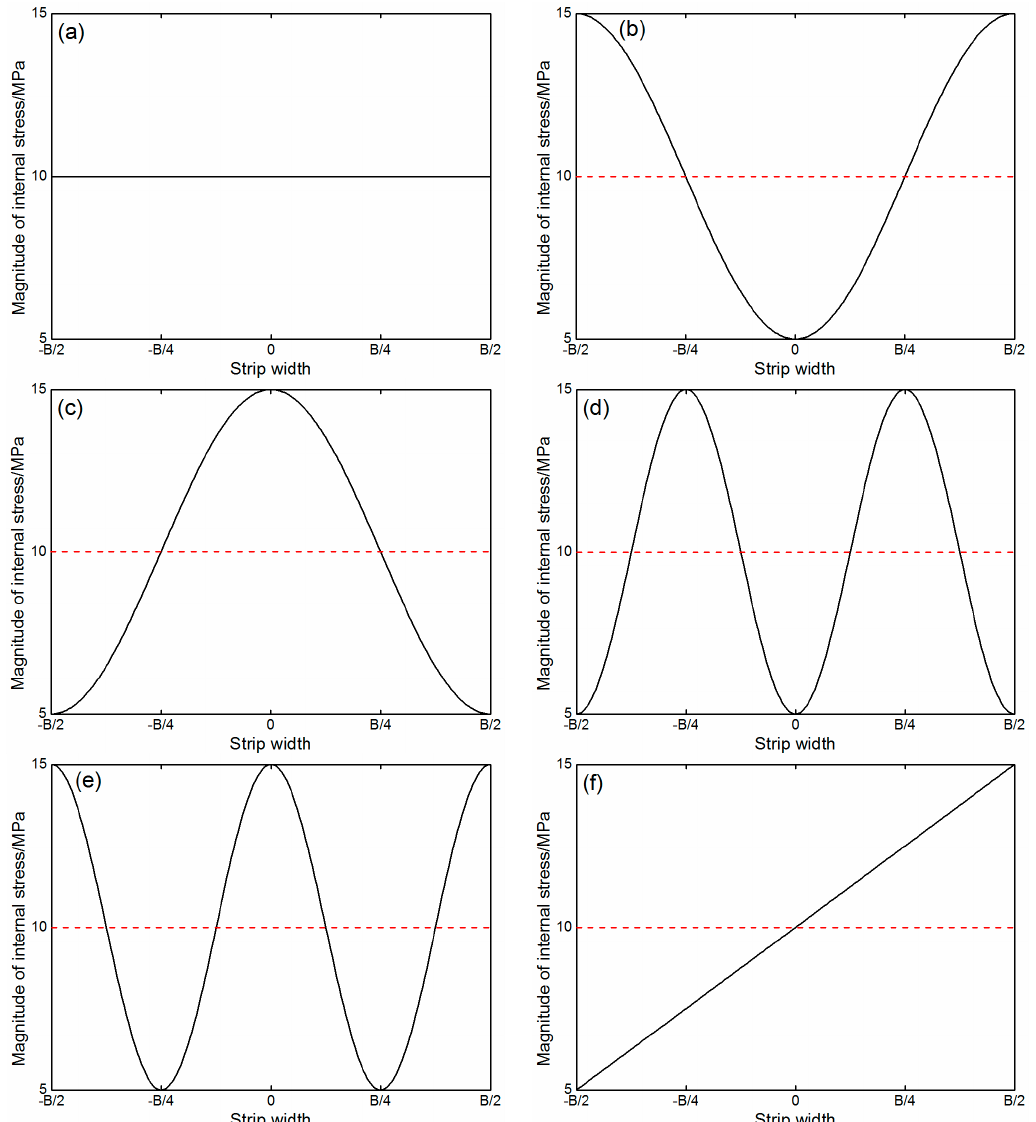
Figure 10. Magnitudes and distributions of typical internal stresses: ( a ) uniform stress; ( b ) middle wave stress; ( c ) double-edge wave stress; ( d ) composite wave stress; ( e ) quartic wave stress; and ( f ) single-edge wave stress.